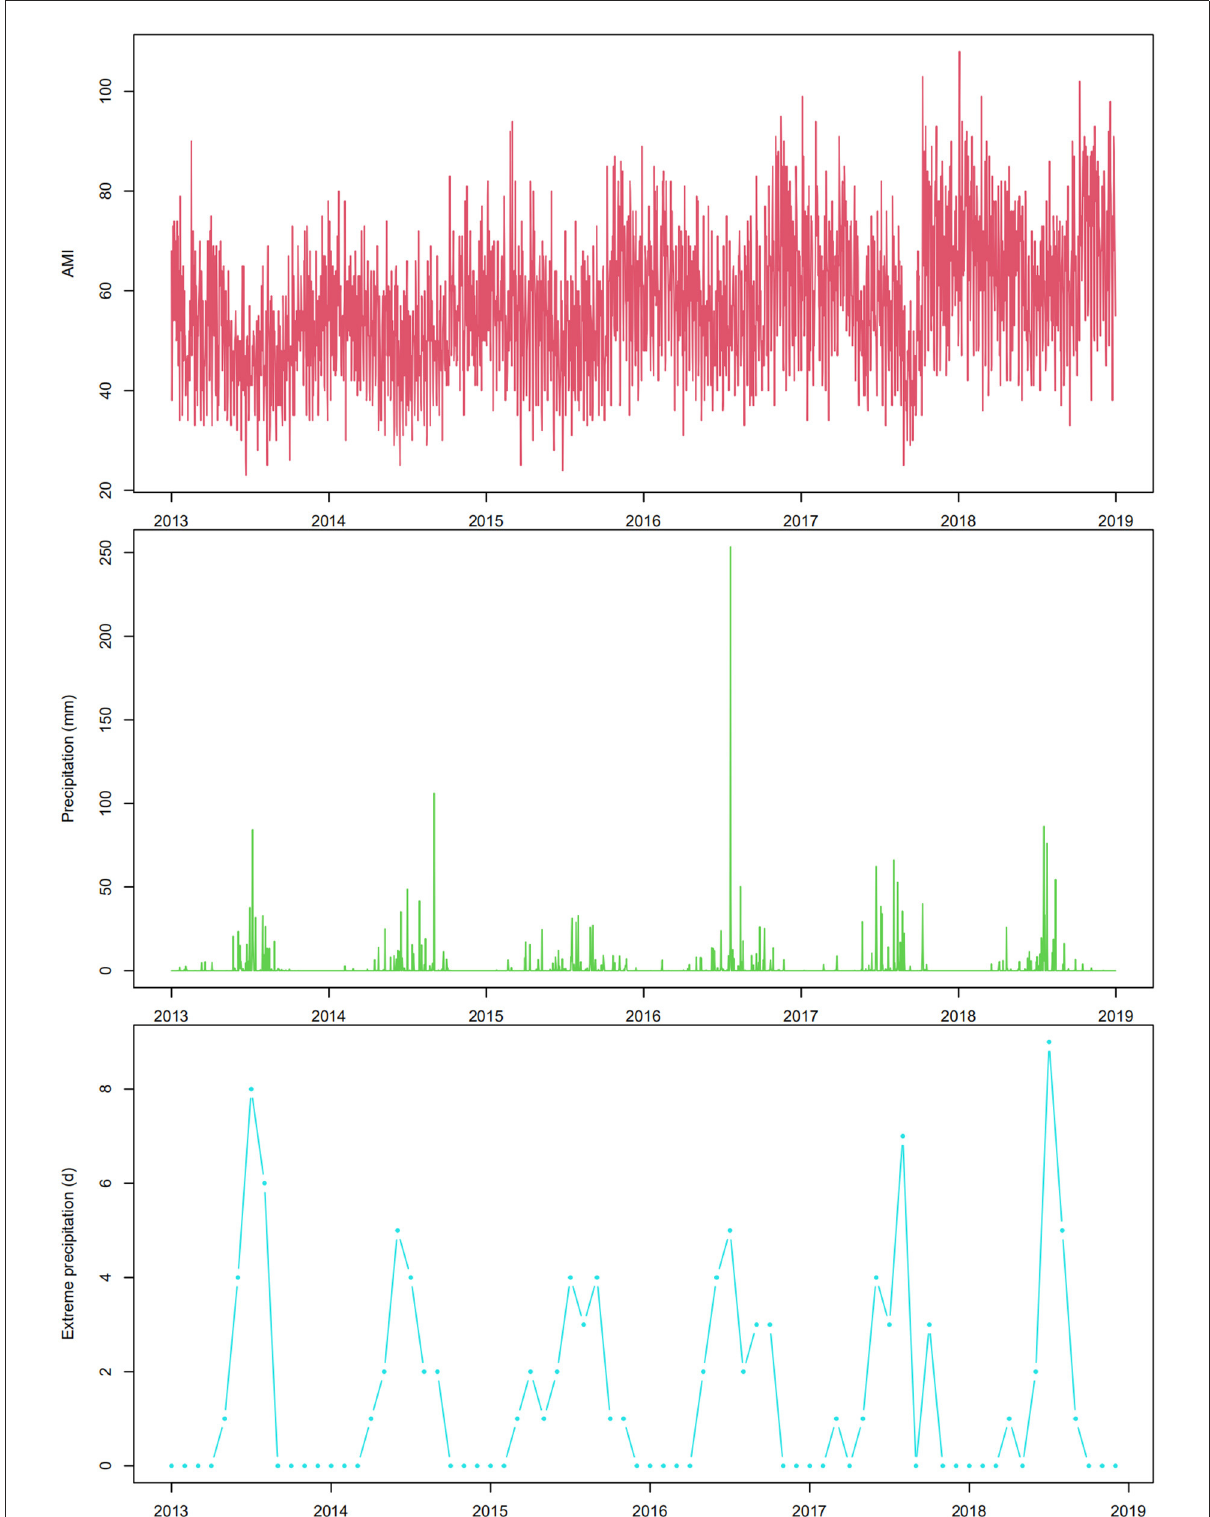
FIGURE2 The time-series plot of daily AMI hospitalizations, daily precipitation, and monthly extreme precipitation events in Beijing, China during